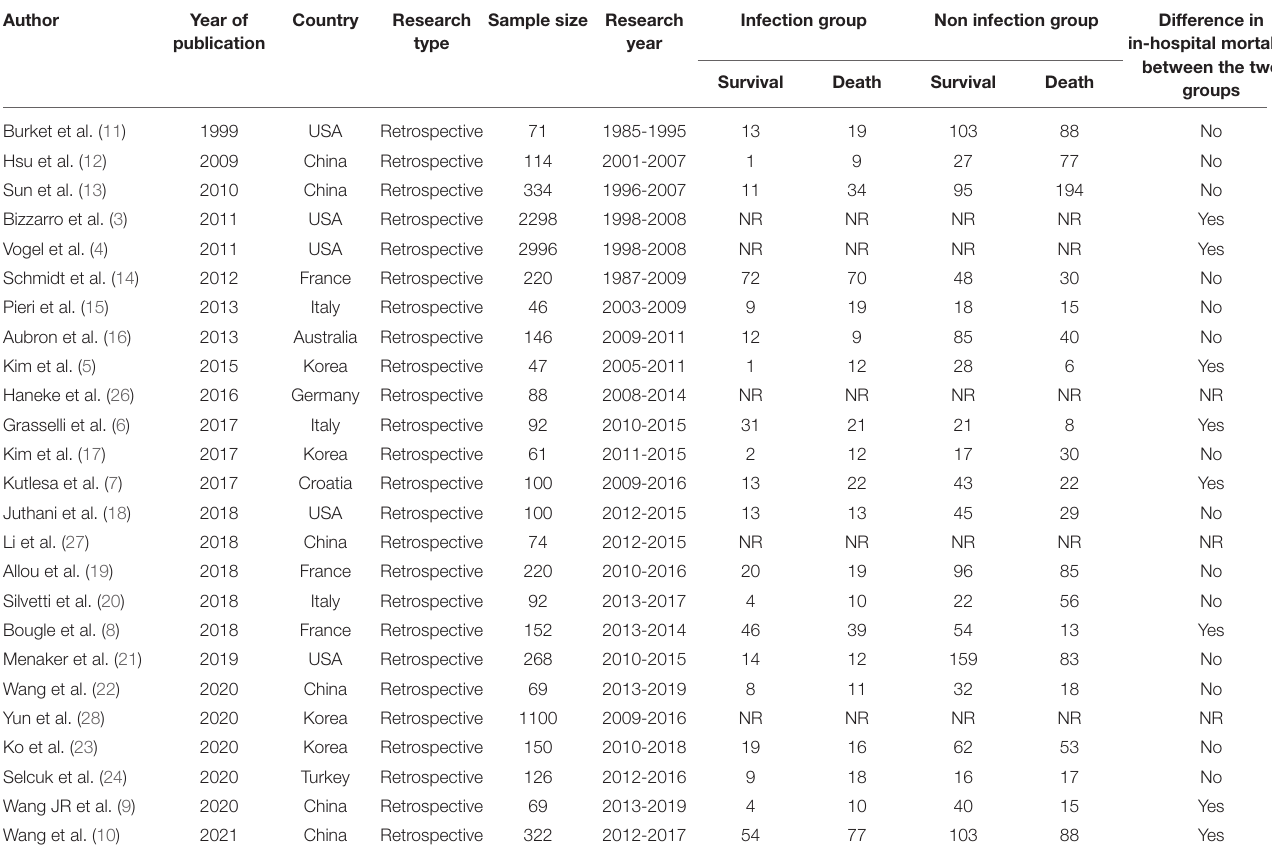
TABLE 2 | List of basic information of the studies